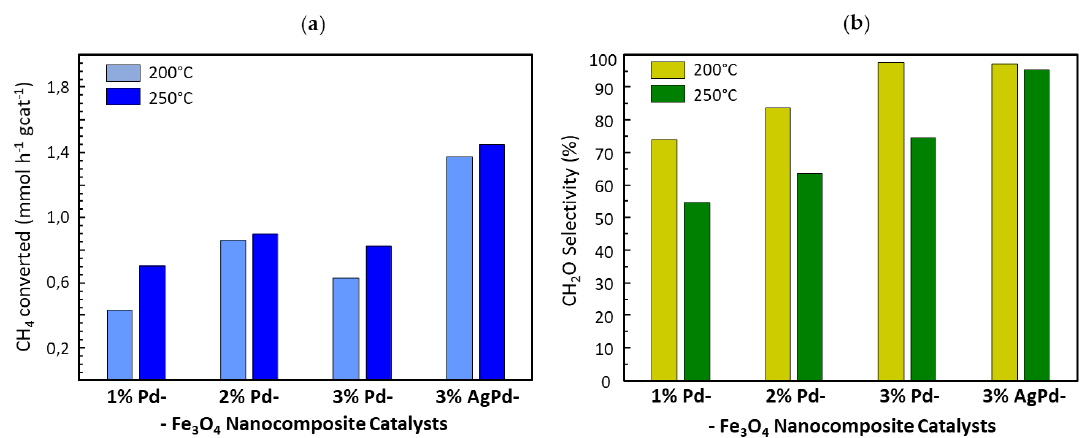
Figure 6. Catalytic activity ( a ) and selectivity to formaldehyde ( b ) for methane partial oxidation over the (Ag)Pd-Fe 3 O 4 nanocomposite catalysts at 200 °C (light color bars) and 250 °C (dark color bars). Reaction conditions: 100 mg catalyst mass, CH 4 / O 2 / He molar ratio of 32 / 4.3 / 63.7, and contact time (W / F, at standard conditions) of 2.6 g cat. h mol CH4 − 1 .